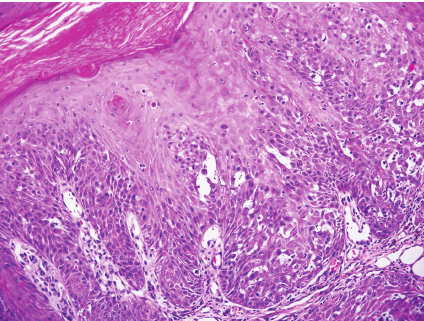
Figure 2: Inverted follicular keratosis: higher magnification show- ing squamous eddies (H&E × 200).